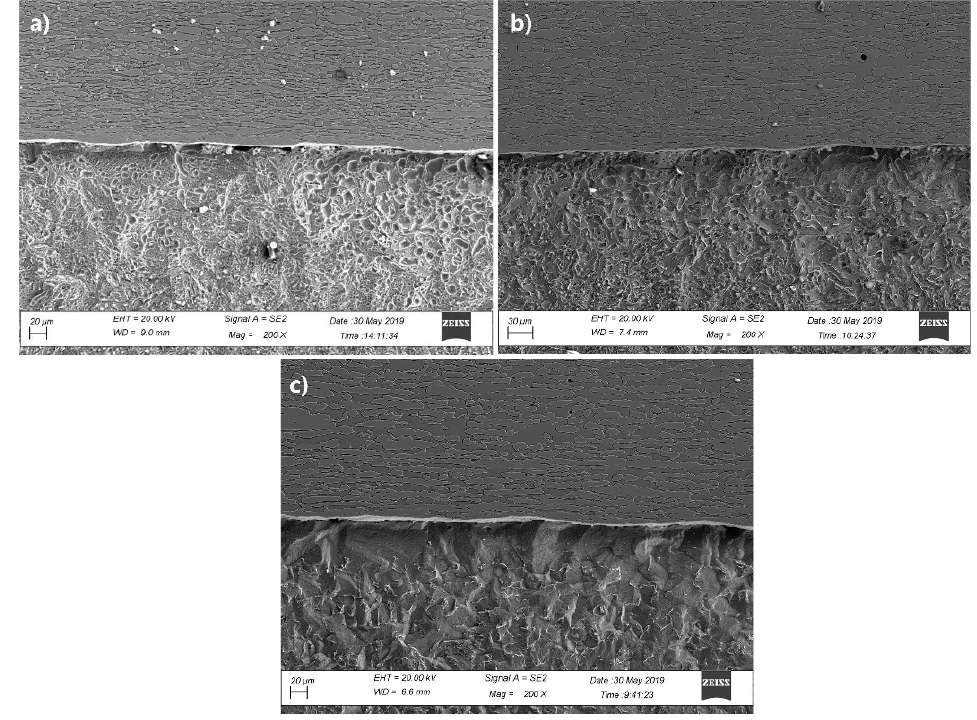
Figure 12. Acid immersion micromorphology of the cross section of the 2205/Q235B composite